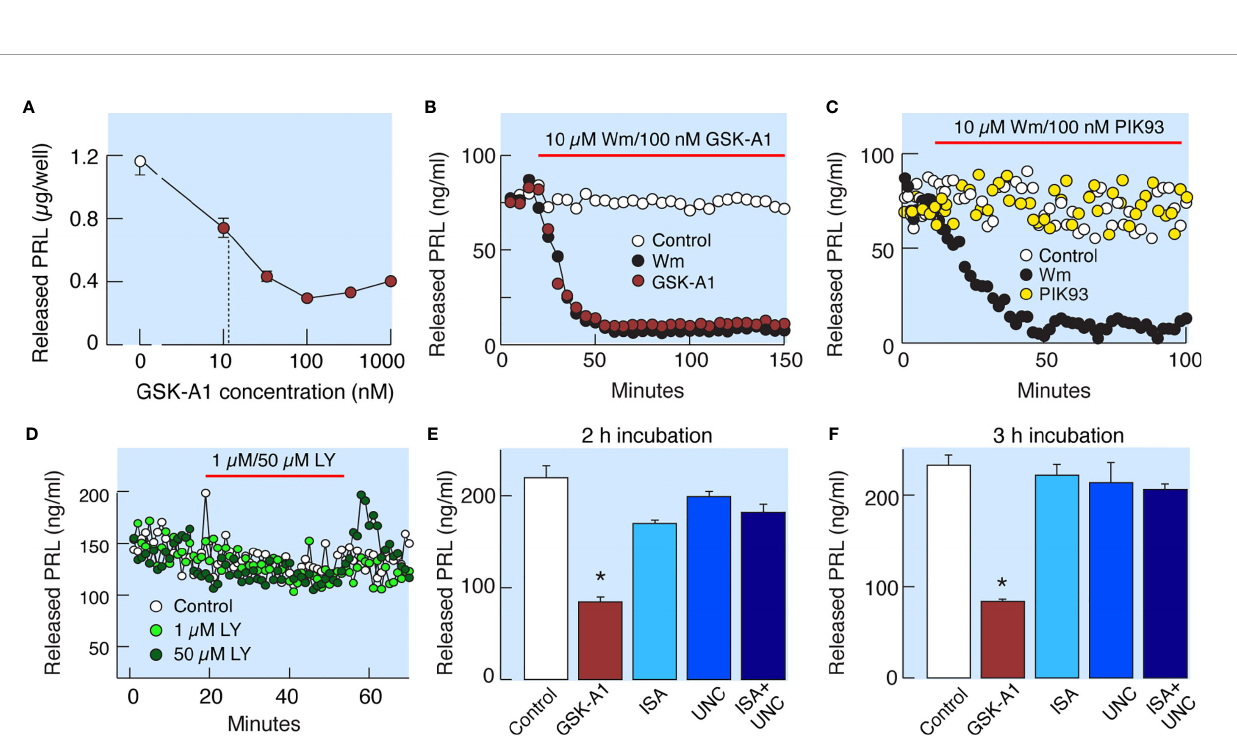
FIGURE 5 | Wm-induced inhibition of PI4KA accounts for inhibition of basal PRL release by Wm in anterior pituitary cells. (A) Concentration-dependence of GSK- A1, a PI4KA-spreci fi c inhibitor, on basal PRL release in static cultures of pituitary cells during 3-h incubation. In subsequent experiments, GSK-A1 was used at a concentration of 100 nM. (B, C) In perfused pituitary cells, the inhibitory effect of Wm on PRL release was fully mimicked by application of GSK-A1 (B) , but not by PIK93, a PI4KB-speci fi c inhibitor (C) . (D) Lack of effects of LY294002 (LY), an inhibitor of PI3KC and other PI3Ks, on basal PRL release. In this and following fi gures, horizontal red bars indicate the duration of treatments with inhibitors and solvents (controls). (E, F) Decrease in basal PRL release by addition of PI4KA but not PIP5K1 inhibitors. Cultured cells were incubated with 100 nM GSK-A1, 10 µM ISA2011B (ISA), 1 µM UNC3230 (UNC), and 10 µM ISA2011B plus 1 µM UNC3230 for 2 h (E) and 3 h (F) . Data points shown in panels (A, E, F) are mean ± SEM of sextuplicate incubation; *P < 0.002 vs control. The released PRL was measured by RIA (A – D) and ELISA (E, F) . For time course of GSK-A1 effects on basal PRL release see also Figure 8B , left, and 9C . The lack of effects of PIK93 on basal PRL release is also shown in Figures 9C, D .